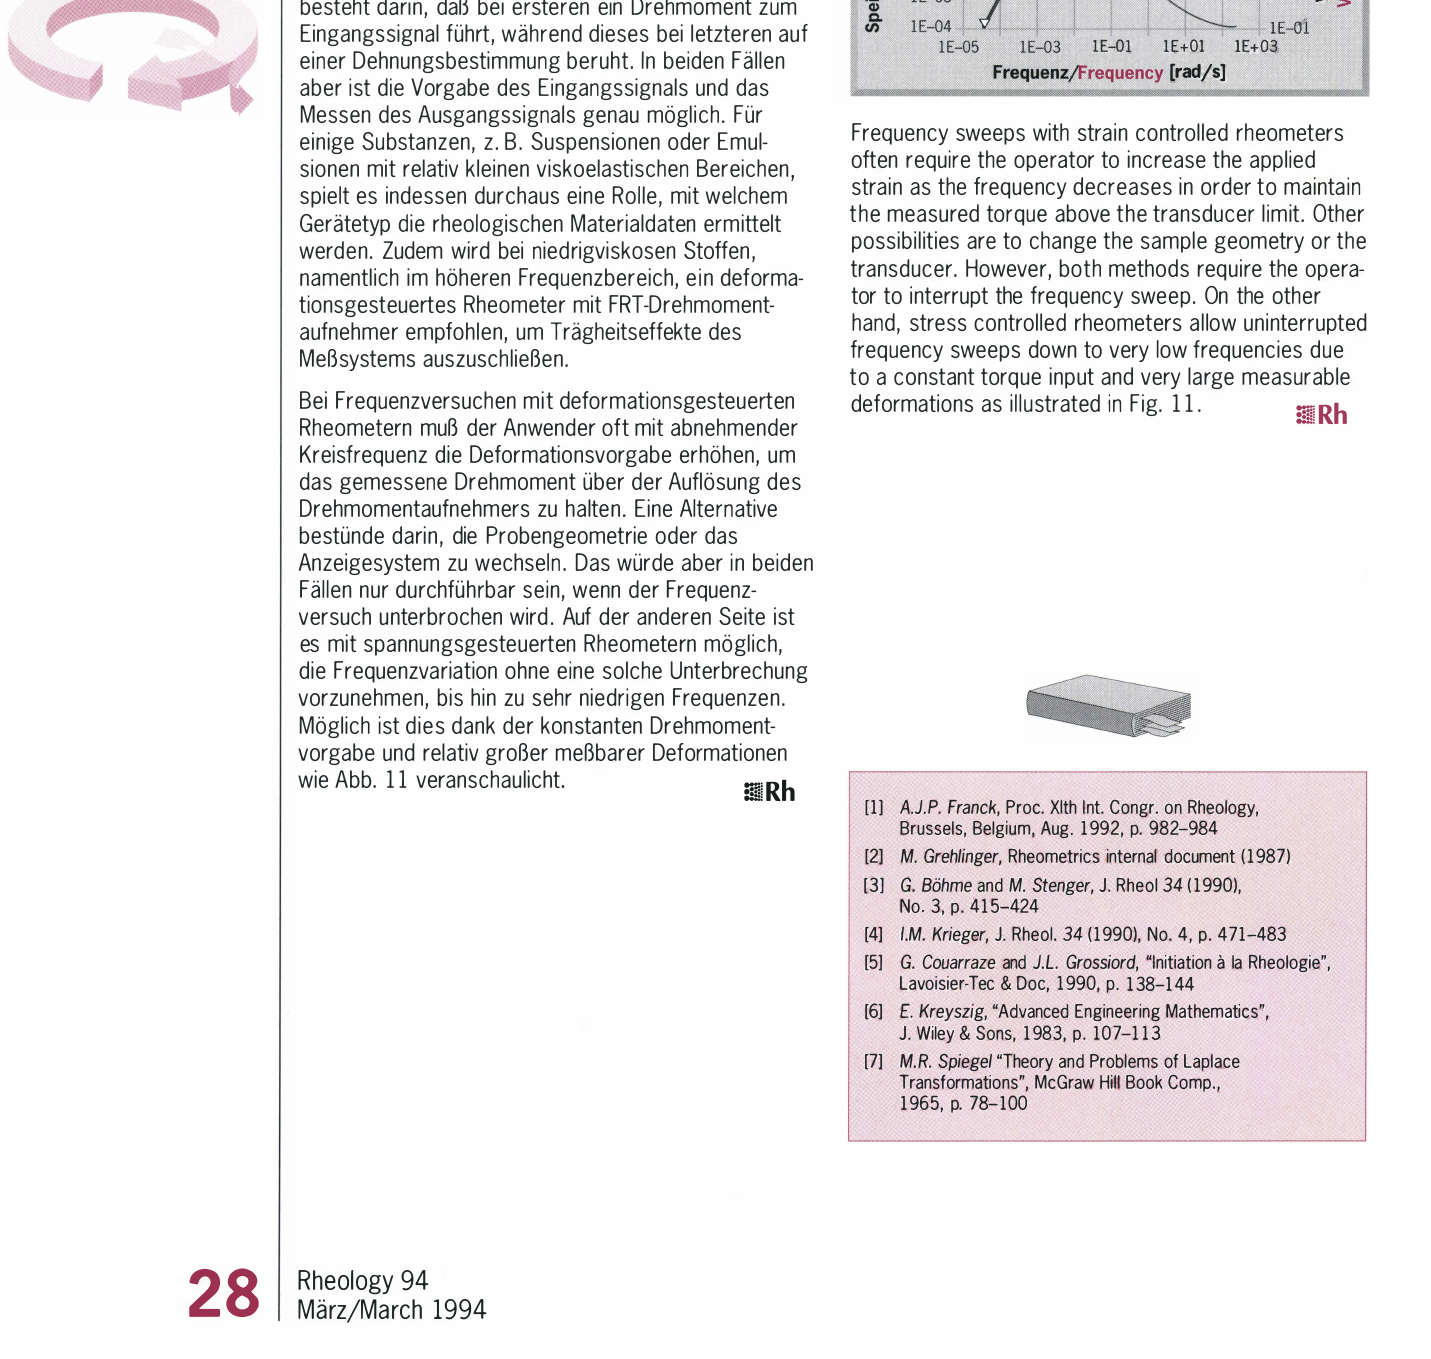
PDMS frequency sweep at 25 oc